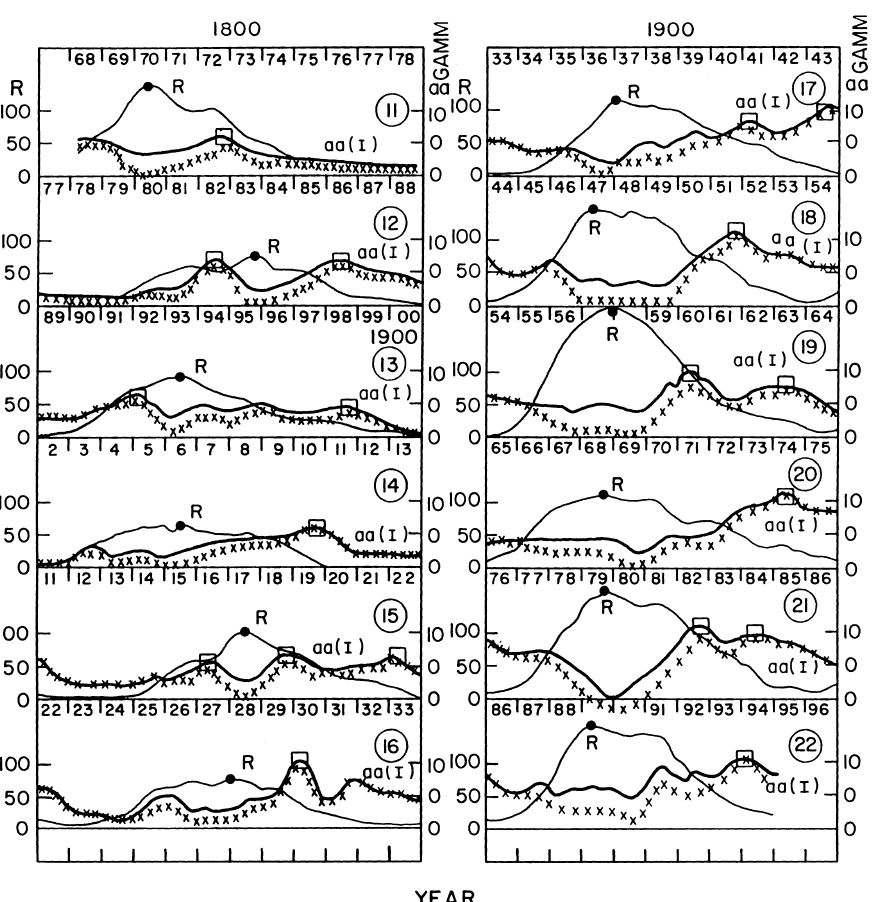
Fig. 2. Sunspot numbers R ( thin lines ) and aa(I) obtained by using direct regression with sunspots ( thick line ) and using Feynman’s regression ( crosses ), separately for each sunspot cycle ( 11-